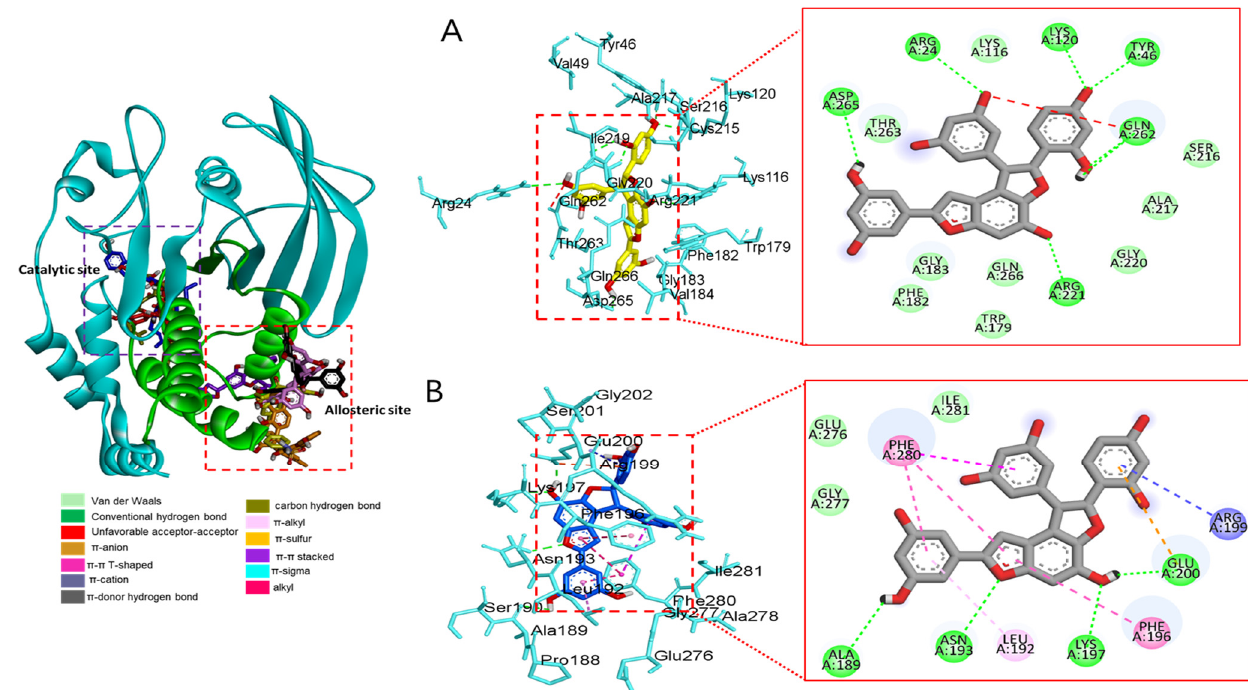
Figure 6. Molecular docking simulation models for PTP1B inhibition by macrourin B at catalytic site ( A ) and allosteric site ( B ). 3D (left) and 2D (right) docking simulations were shown at each binding site. Interaction was di ff erentiated by various color (left bo tt om).